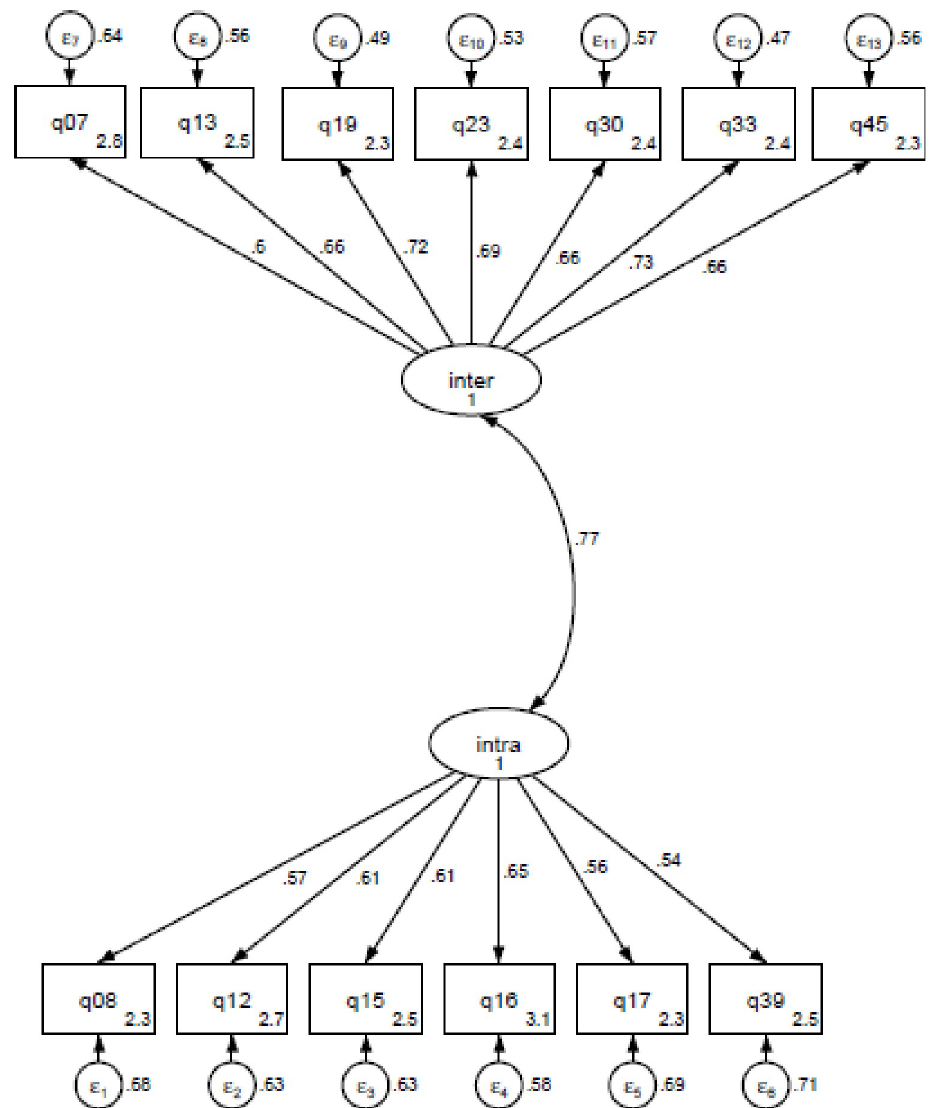
Fig 2. Confirmatory factor analysis of the Short-PEC. Adjustment of the model to the scale: Chi-squared = 4.033, RMSEA = 0.075 ( < 0.08) [90% CI 0.066–0.085], a SRMR = 0.048 ( < 0.08), a TLI = 0.897 ( < 0.90), a CFI = 0.915 ( > 0.90), and a GFI = 0.89 (not >